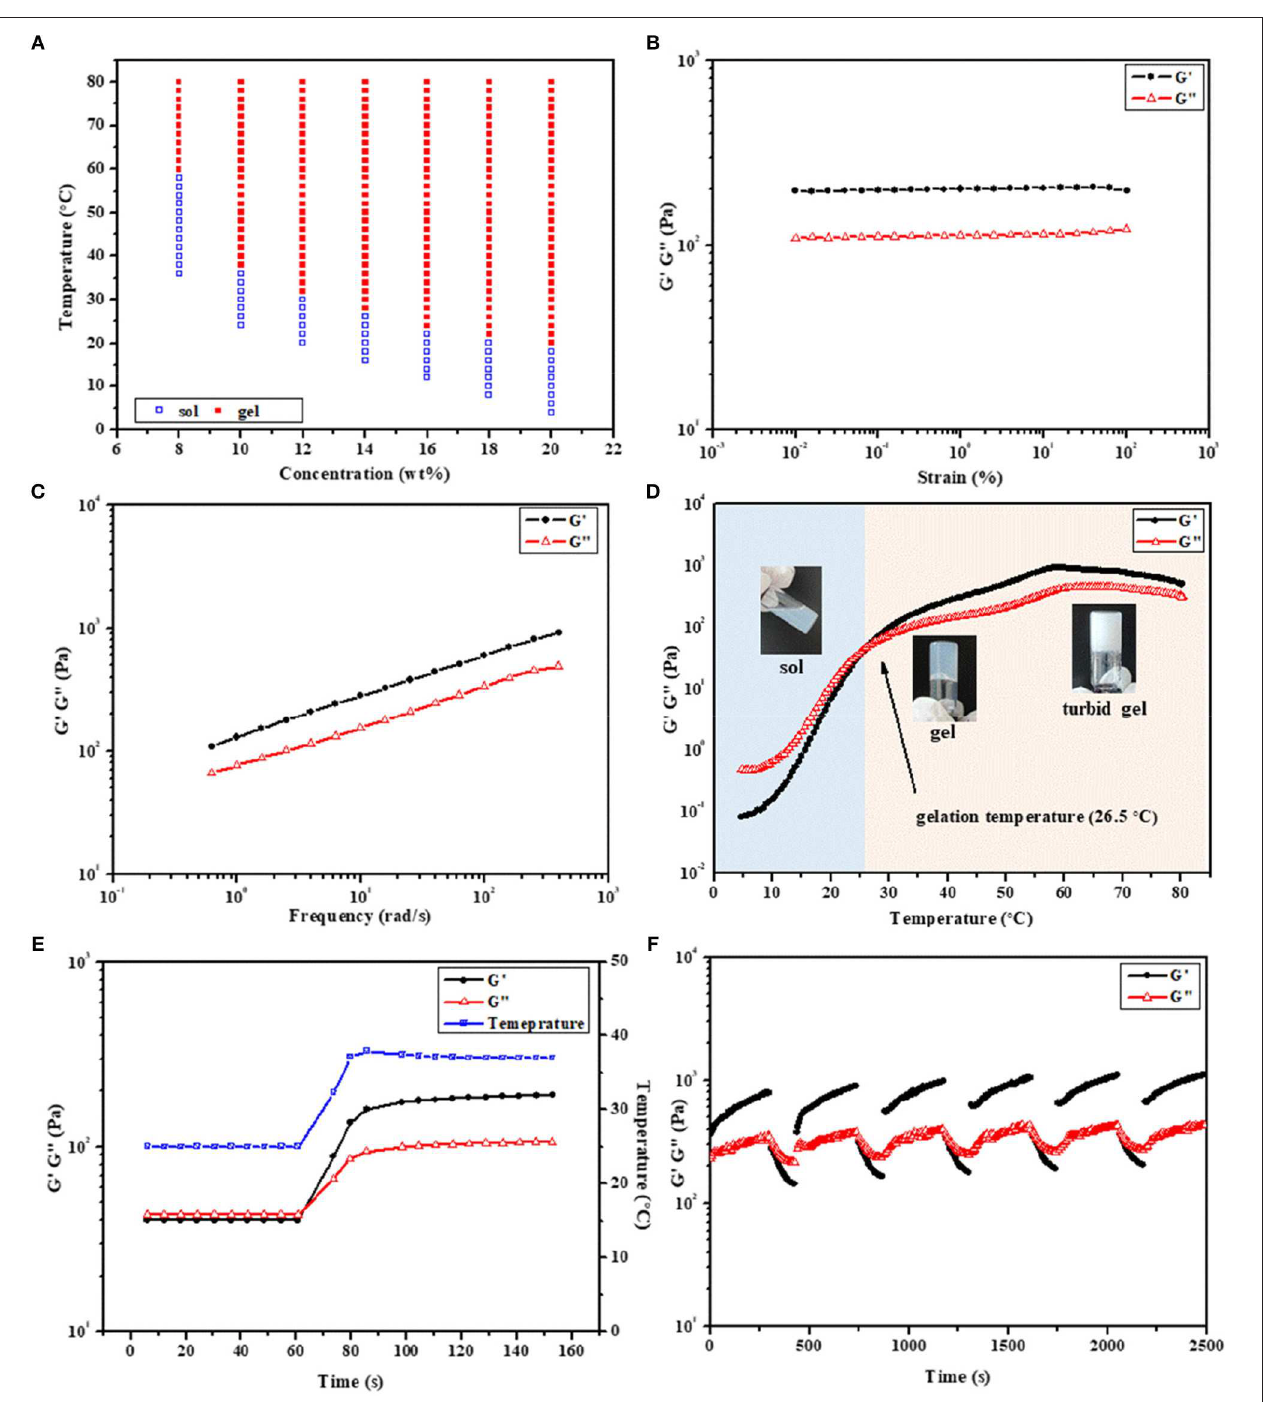
FIGURE 4 | (A) Phase diagrams of 2PDEP in aqueous solutions. Storage modulus (G’) and loss modulus (G”) of (B) amplitude sweep (0.01–100%, 1Hz, 37 ◦ C), (C) frequency sweep (1%, 0.1–100Hz, 37 ◦ C), (D) temperature sweep (1%, 1Hz, 4–80 ◦ C) and (E) temperature ramp (1%, 1Hz, 25 to 37 ◦ C) for 2PDEP aqueous solution (12 wt%) obtained from dynamic rheological analysis. (F) Self-healing cycle amplitude sweep (0.01 and 50%, 1Hz, 37 ◦ C) for 8PDEP aqueous solution (16 wt%) obtained from dynamic rheological analysis.